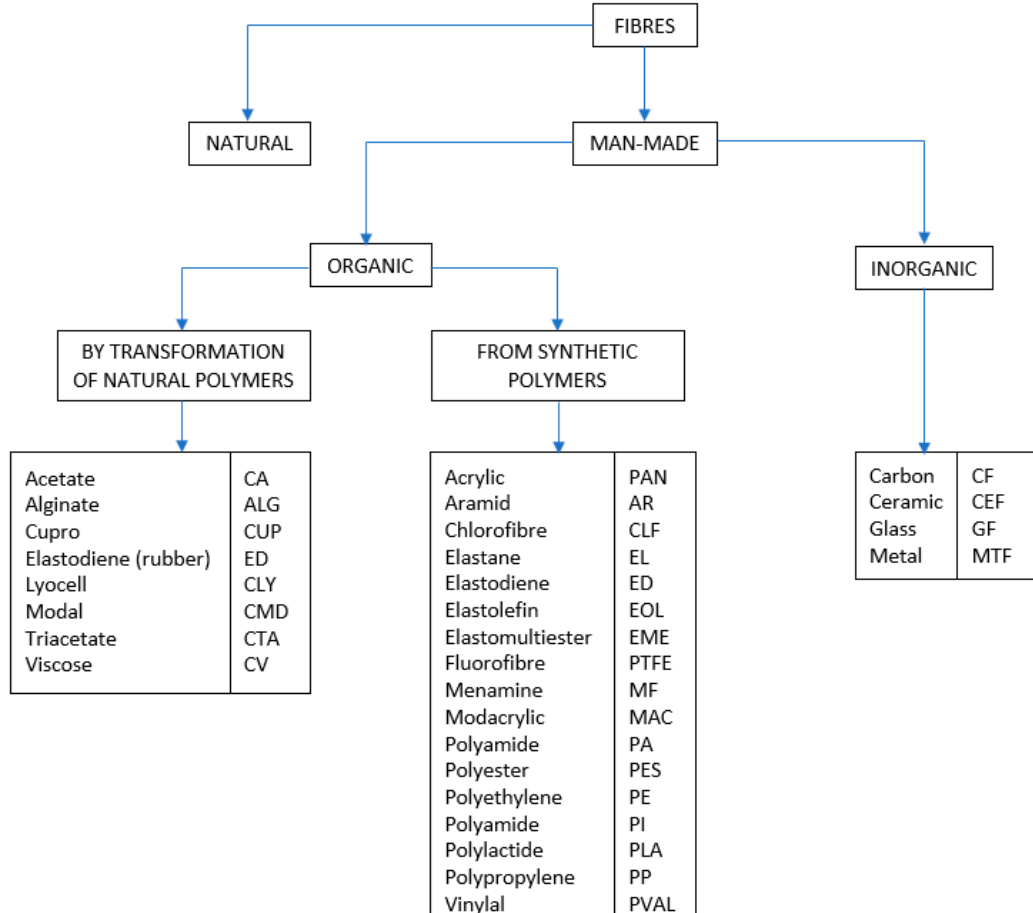
Figure 7. The common man-made fibers of conventional use for the architectural design of building envelopes (reproduced from [54]). envelopes (reproduced from